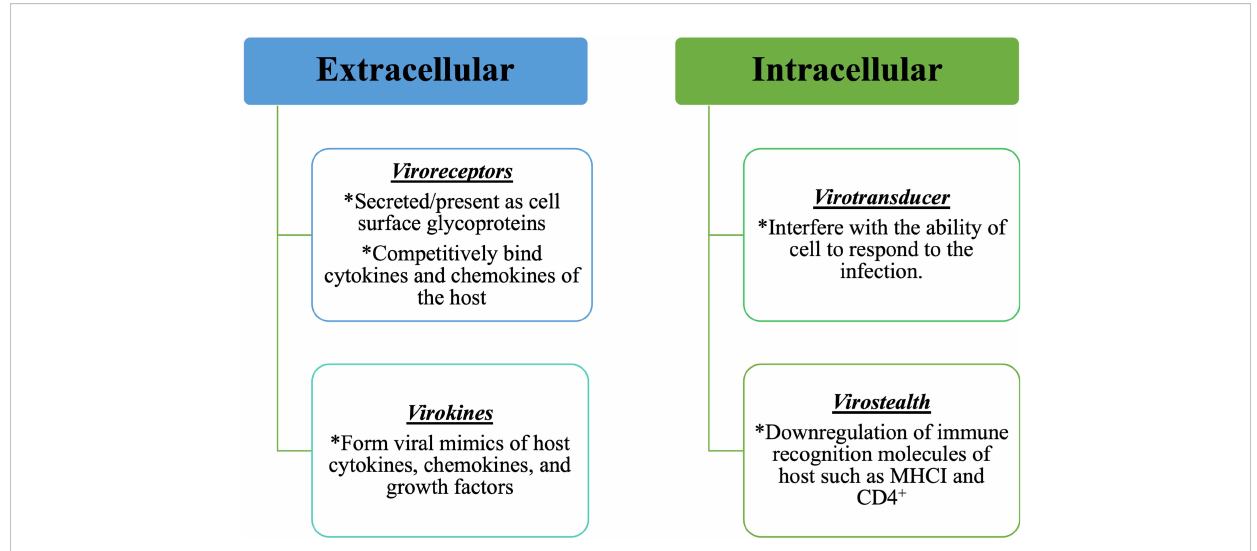
FIGURE 2 Monkeypox proteins responsible for modulatory action against immune response of the